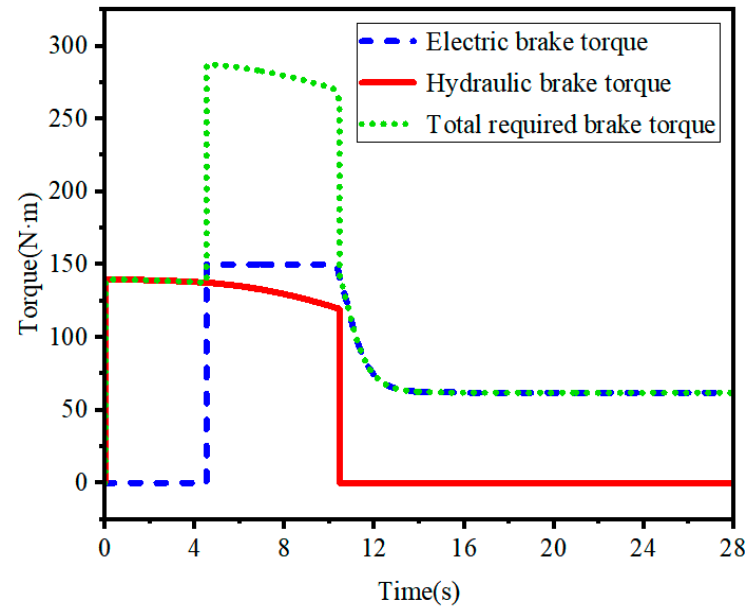
Figure 10. Diagram of the output torque.